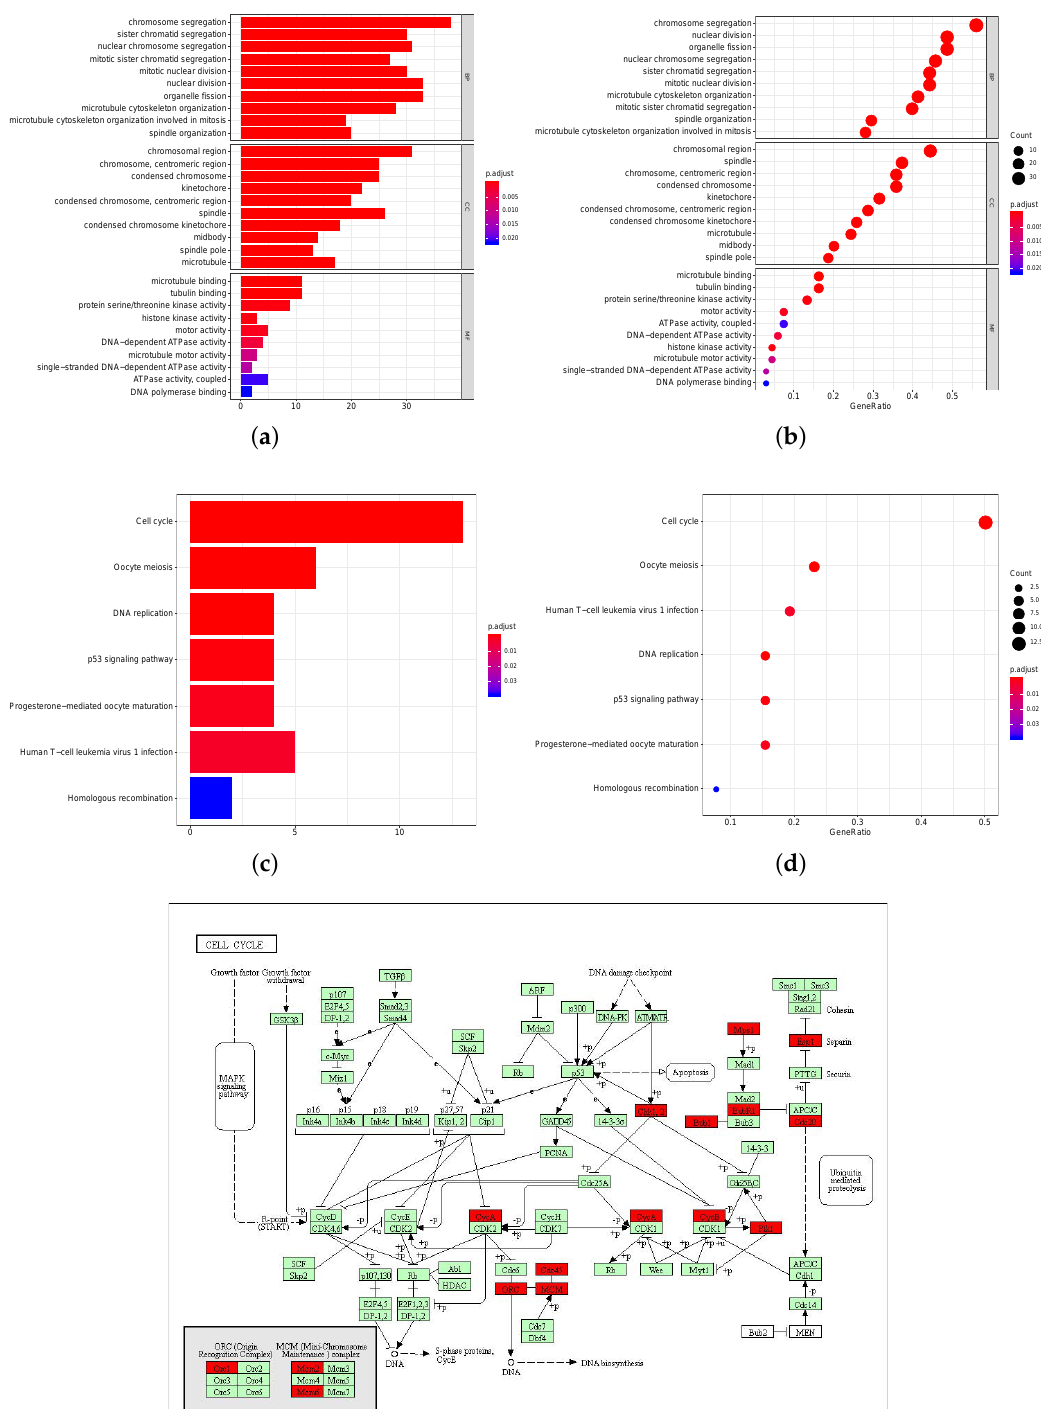
Figure 7. The Gene Ontology (GO) term and Kyoto Encyclopedia of Genes and Genomes (KEGG) pathway analysis for key genes from the blue module. The significant terms and pathways are represented by the negative decadic logarithm of the enrichment adjusted p -value (the longer bars indicate more